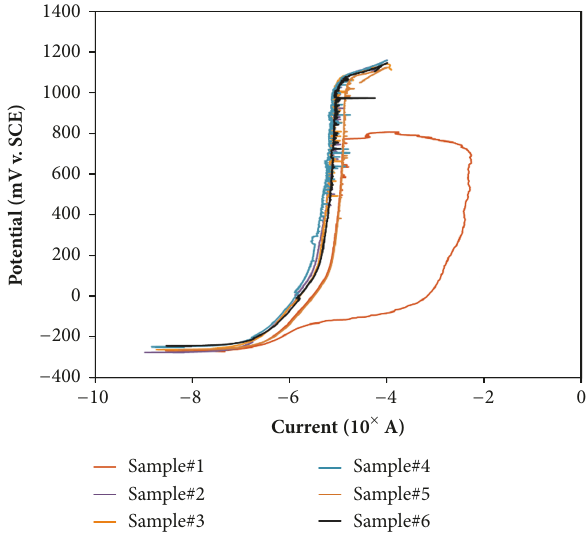
Figure 7: Potential vs. current curves for combustion synthesis porous Nitinol.